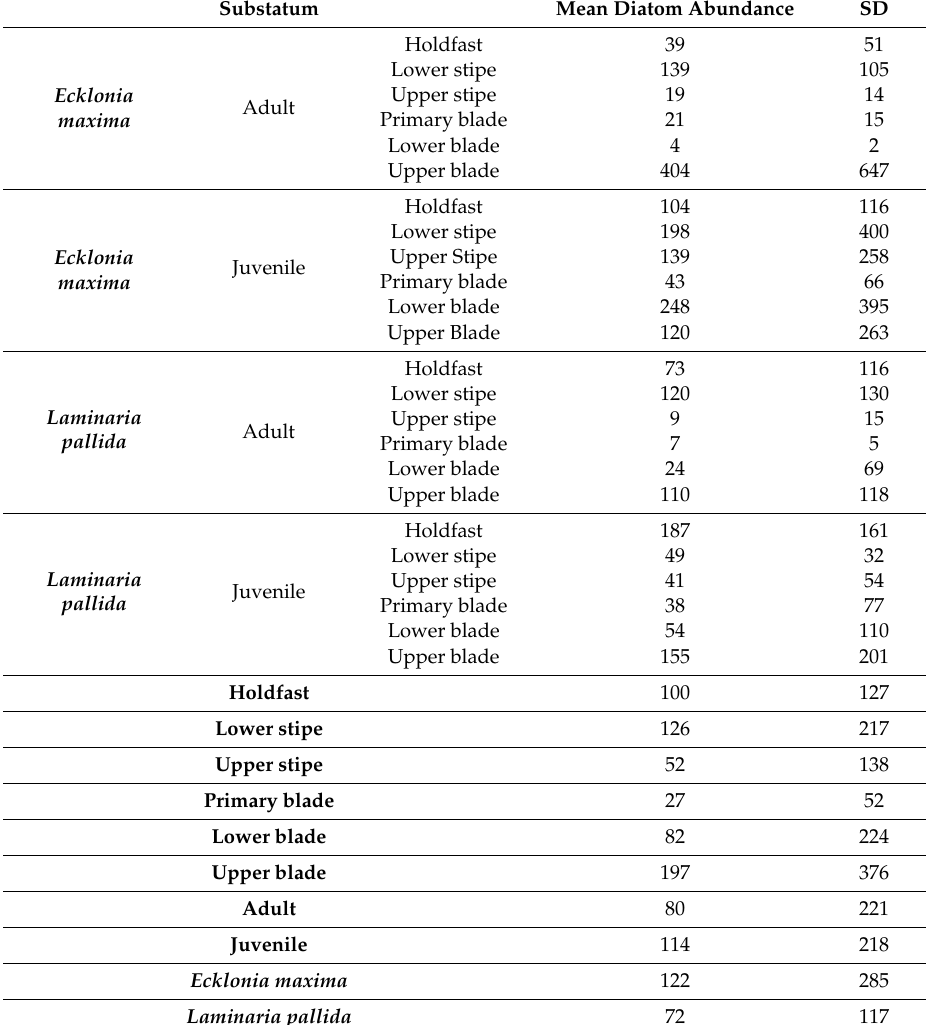
Table 1. Mean diatom abundance (cells mm − 2 ) and standard deviation (SD) calculated for di ff erent thallus parts of adult and juvenile specimens of Ecklonia maxima and Laminaria pallida